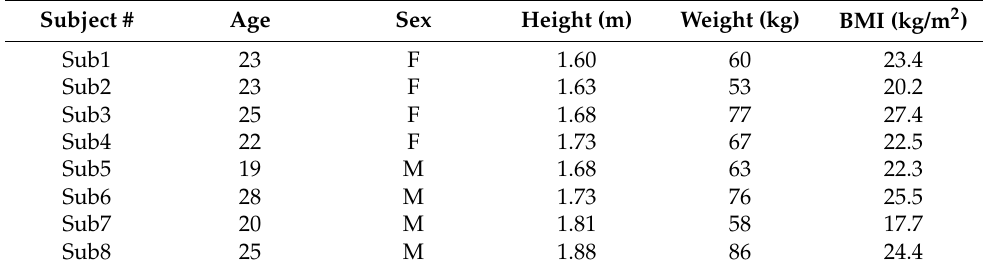
Table 1. The participants’ demographics (Phase